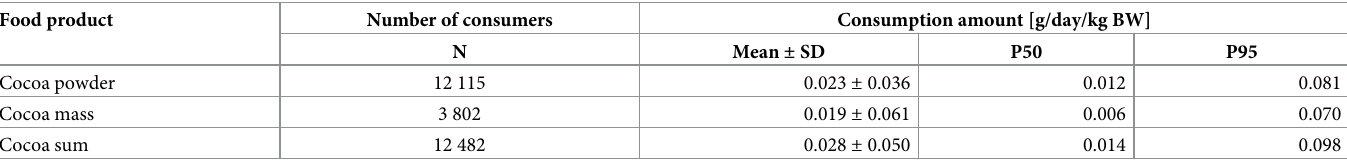
Table 1. Cocoa consumption in Germany according to German National Nutrition Survey II (NVS II) dietary history interview–consumers only. N number of con- sumers as a subset of 15371 participants in NVS II dietary history interview (frequency and quantity of foods and beverages usually consumed over four weeks, participants aged between 14 and 80 years). Consumer characteristics: 48.8% male (age: 43.7 ± 17.3 years; BW: 83.3 ± 14.9 kg), 51.2% female (age: 45.0 ± 17.9 years; BW: 69.3 ± 14.4 kg). BW body weight, SD standard deviation, P50 percentile 50, P95 percentile 95. BLS codes: cocoa powder (not specified S7100??, in general S710000, slightly